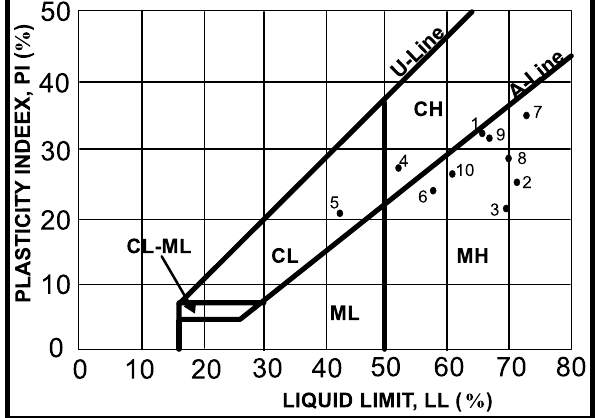
Figure 8: Plasticity Chart of Soil Samples